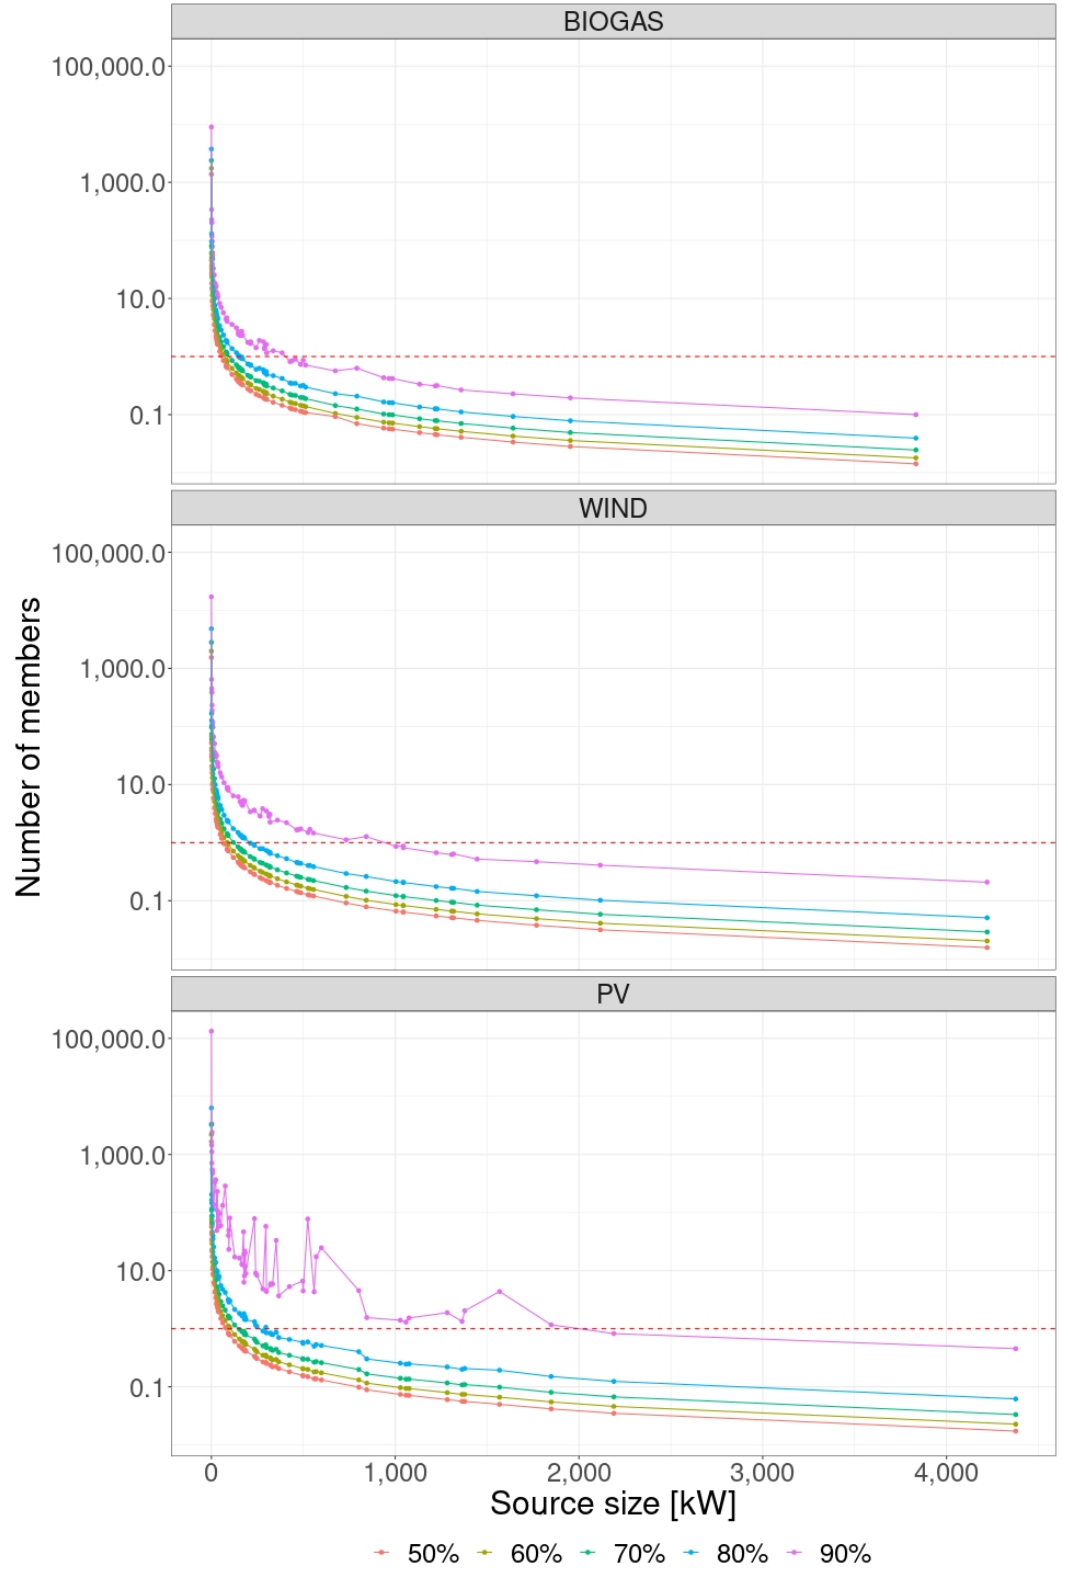
Figure 8. Empirical dependency of the number of cooperative members as a function of the capacity of generating